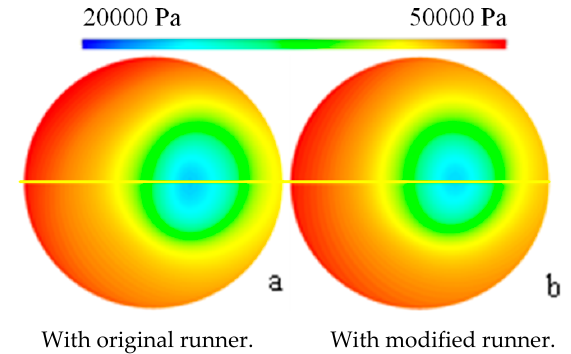
With original runner. With modified runner. Figure 8. Cavitation rope structured by iso-surface of vapour volume fraction.